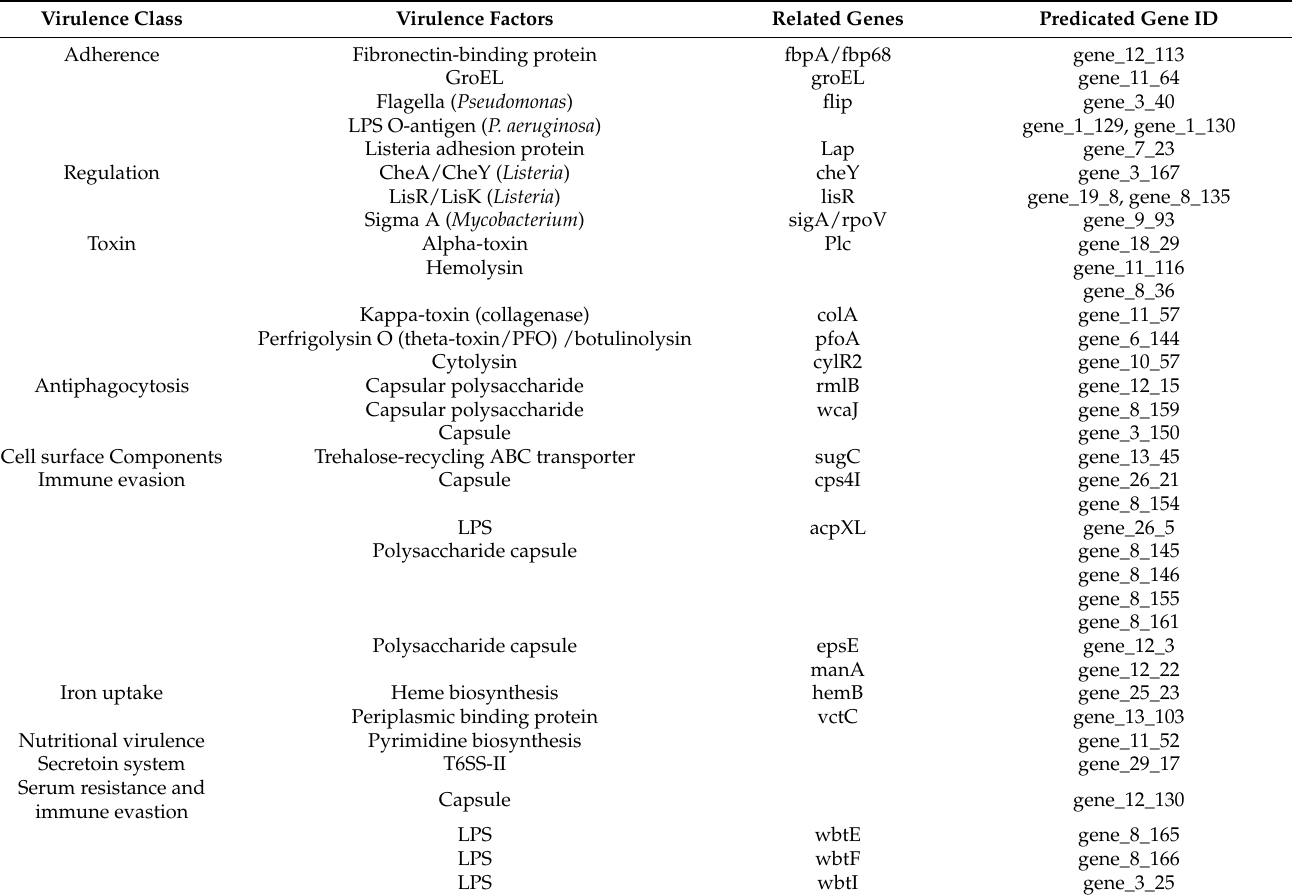
Table 3. Virulence factors present in the P. bifermentans GBRC